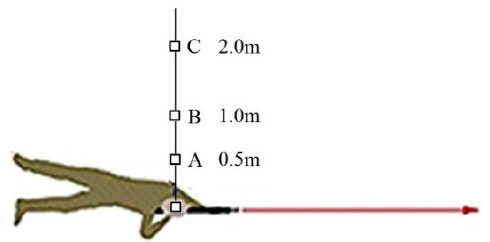
Figure 16. Diagram of receiver locations.